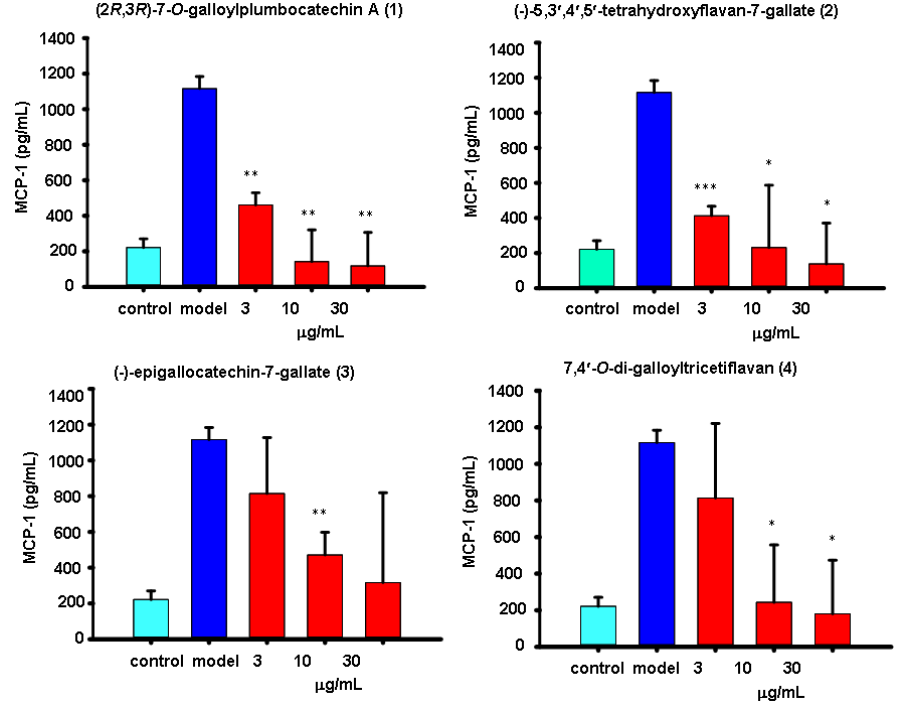
Figure 5. The results of treatment with the four flavonoids 1 – 4 at 3, 10 or 30 μ g/mL on the production of MCP-1 in H1N1-infected A549 cells. At 24 h post infection, the level of MCP-1 in the supernatants was measured by ELISA. Data are presented as the mean ± SD of three separate experiments. * p < 0.05, ** p < 0.01, *** p < 0.001 compared with